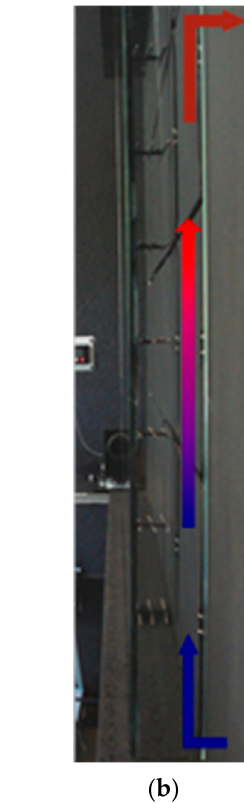
Figure 1. Experimental laboratory model: frontal view ( a ) and lateral view of the ventilated cavity with airflow arrows ( b ). Table 1. Structure and physical properties of the open joint ventilated facades (OJVF) laboratory model.